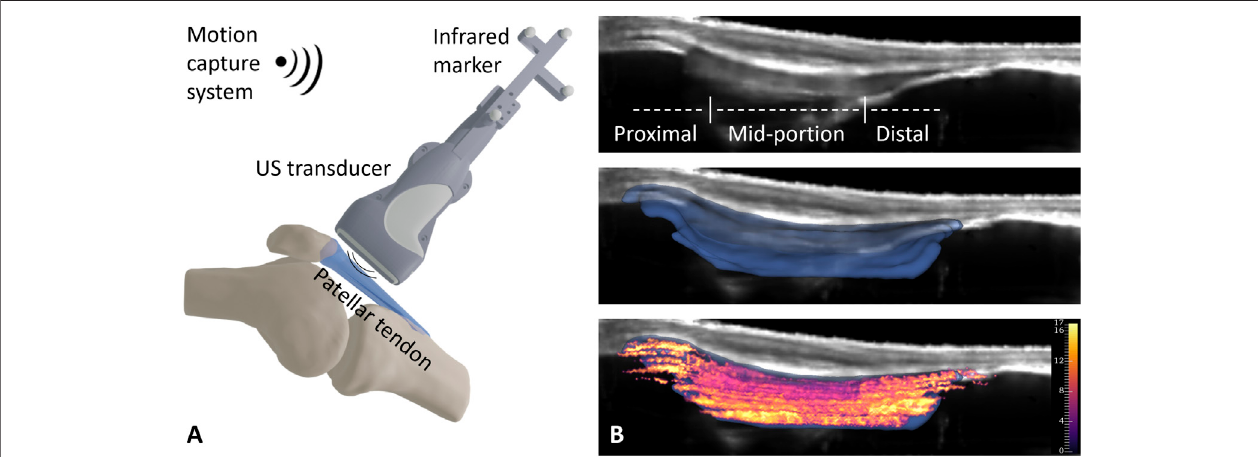
FIGURE 1 | Schematic depiction of the ultrasound shear wave elastography analysis. (A) Ultrasound B-mode and shear wave elastography measurements were acquired with a linear ultrasound probe equipped with optical markers. (B) Two-dimensional measurements were projected into three-dimensional space to yield volumetricB-modeandshearwaveelastographyrepresentations(topimage).Thepatellartendonwassegmented(middleimage),andthesegmentationwasappliedto the shear wave elastography volume (bottom image).